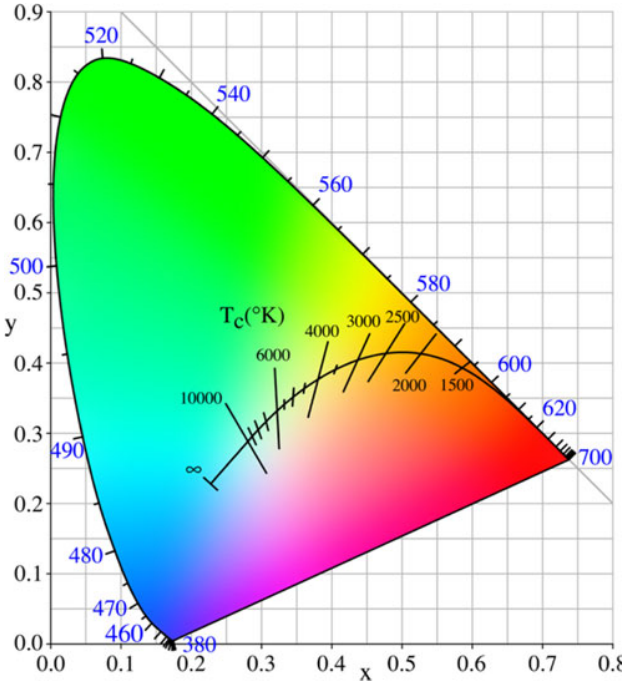
Figure 3. CIE 1931 color space chromaticity Fig. 1. CIE 1931 color space chromaticity diagram with wavelengths dis- played in nanometers. The blackbody line is shown within the range of CCT from 1500 K to 10 000 K.